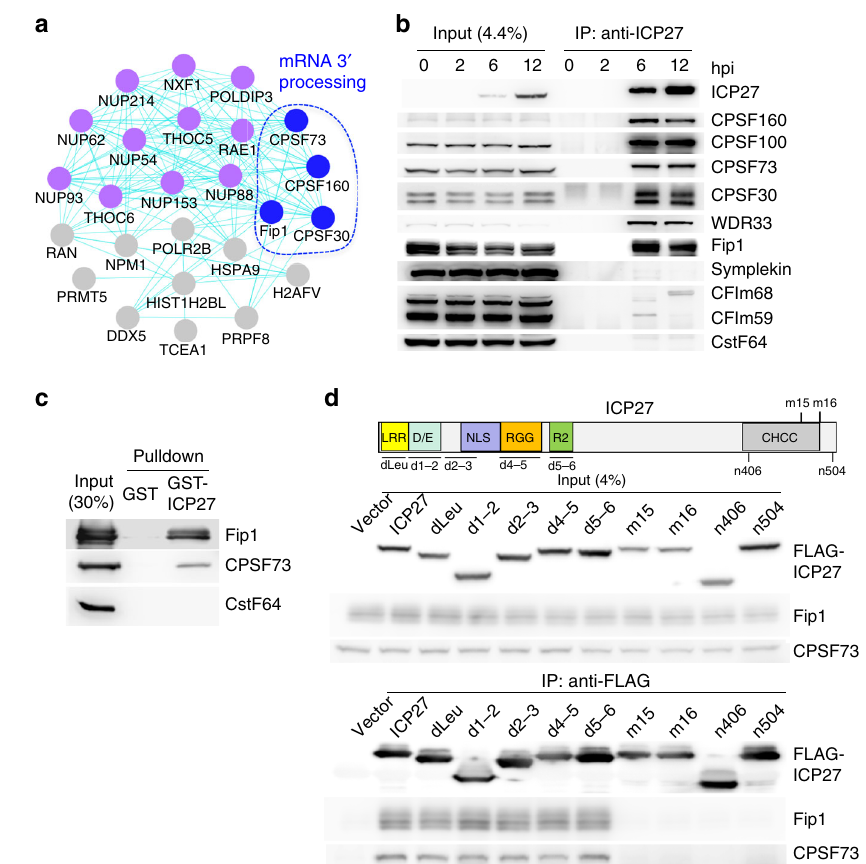
Fig. 3 ICP27 directly interacts with CPSF and the mRNA 3 ′ processing machinery. a A network plot of the top ICP27-associated host factors. The purple dots are factors with known functions in mRNA export and the blue dots are mRNA 3 ′ processing factors. The plot was based on STRING. b Cells infected with WT HSV-1 (KOS) were harvested at different time points post-infection and subjected to immunoprecipitation with an anti-ICP27 antibody. Input and IP samples were analyzed by western blotting. c In vitro pulldown assays with GST-ICP27 and recombinant Fip1, CPSF73, and CstF complex. The input and pulldown samples were analyzed by western blotting. d Top panel: a diagram of known domains in ICP27 protein and the regions deleted in the mutant ICP27 proteins are marked below. Lower panel: WT or various mutant Flag-tagged ICP27 were expressed in cells via transient transfection and IP was performed with anti-Flag antibody. The input and IP samples were analyzed by western blotting. Source data are provided as a Source Data fi